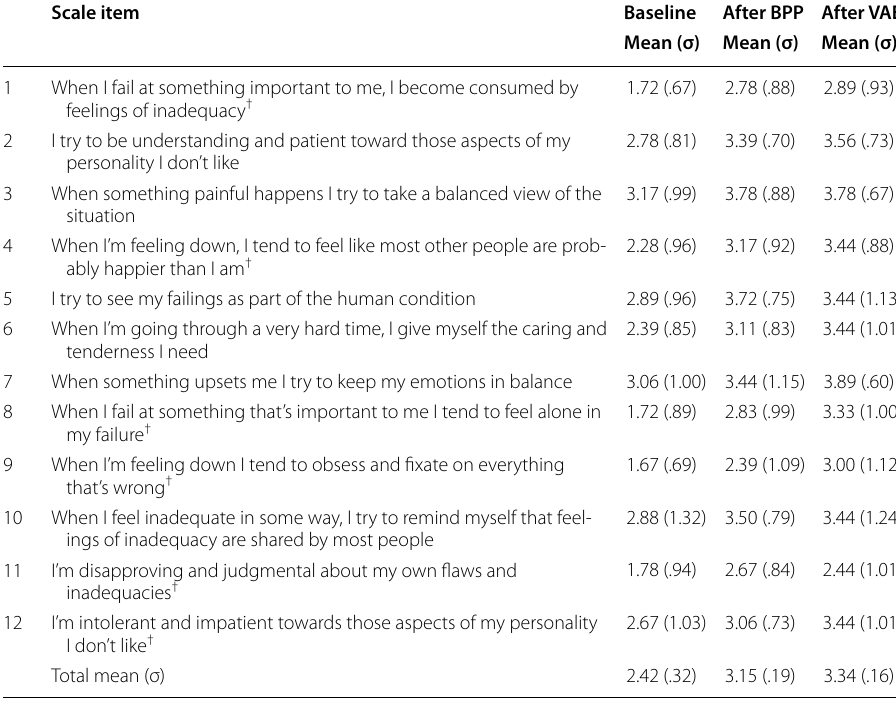
Table 4 Self-compassion scores across the intervention